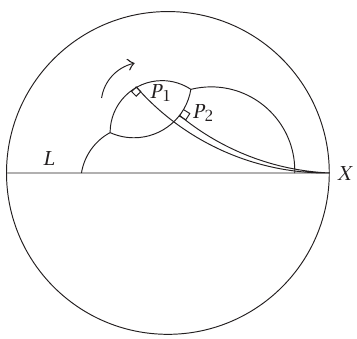
Figure 7.5 . Generating curve for a possible nonstandard minimizer, and a set of points p i from which orthogonal lines meet the axis of revolution at the same infinity.